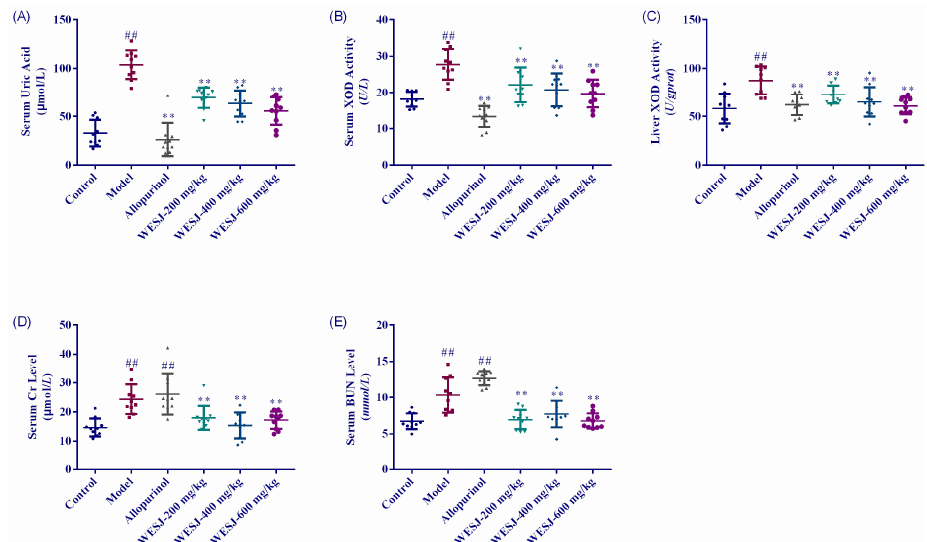
Figure 4. Biochemical effects of WESJ on hyperuricemic mice. ( A ) Levels of UA in serum; ( B ) levels of XOD in serum; ( C ) levels of XOD in the liver; ( D ) levels of Cr in serum; ( E ) levels of BUN in serum. Data were expressed as mean ± S.E.M. ( n = 10). ## p < 0.01, compared with control group; ** p < 0.01, compared with model group.